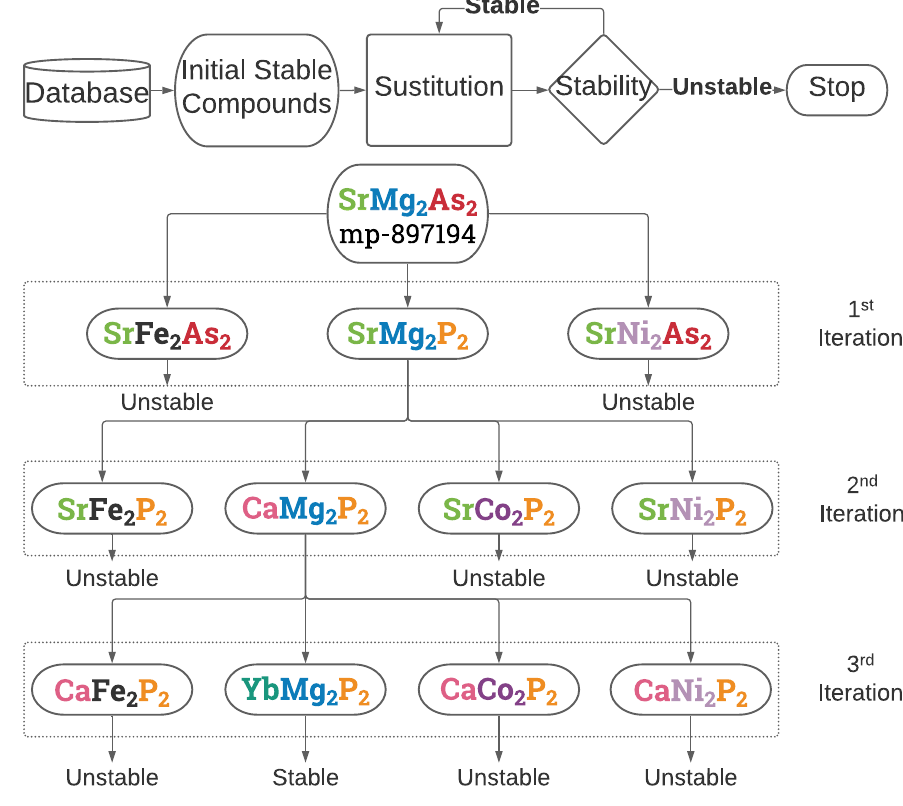
Fig. 7 Work fl ow. An illustration of a work fl ow for predicting stable materials based on